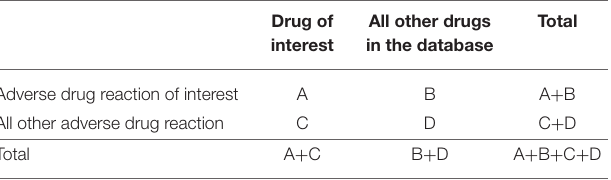
TABLE 2 | Reporting odds ratio (ROR) algorithm